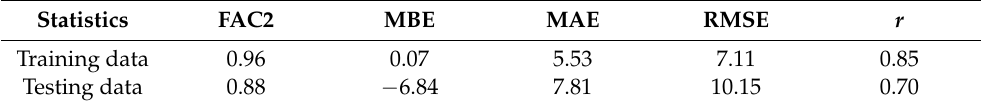
Table 6. Model statistics showing the value of several metrics in assessed the model performance by comparing observed and predicted NO 2 concentrations ( µ g/m 3 ) for testing and training data, using NO as exogenous variables. MBE, MAE and RMSE are expressed in µ g/m 3